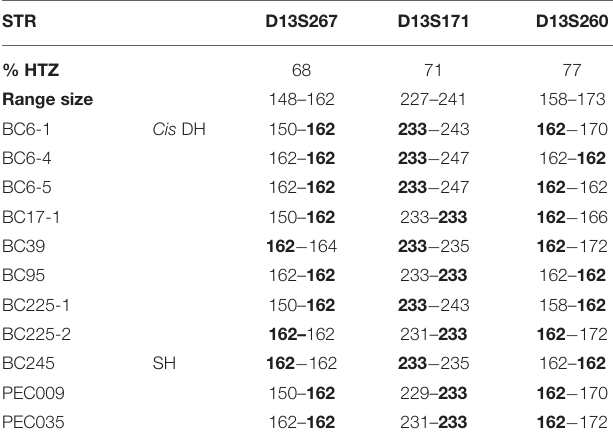
TABLE 4 | Haplotype analyses in the carriers of both BRCA2 deleterious